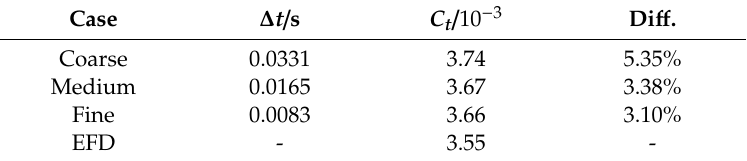
Table 7. The numerical uncertainties of resistance of the 1:31.6 scaled model. Convergence r k R